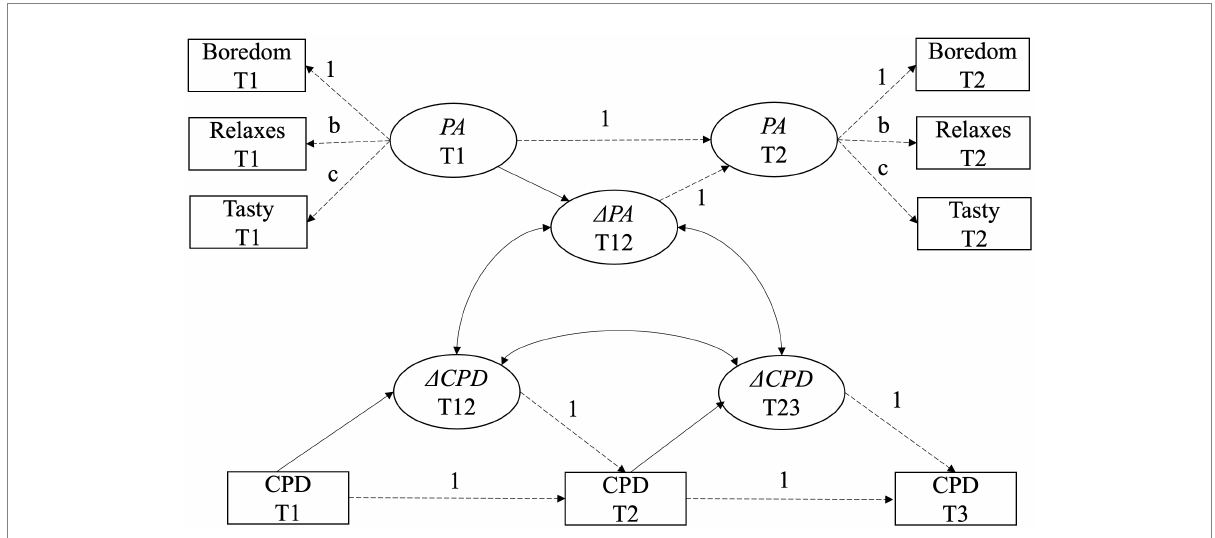
FIGURE 1 Specified latent change score model for changes in positive attitudes (PA) and its associations with changes in cigarettes smoked per day (CPD) between pre- (T1), post- (T2), and follow-up (T3) assessment. Δ symbolizes latent change scores; dashed arrows reflect fixed or constrained paths. Cross-time correlations between the same items across measurement occasions are left out to enhance